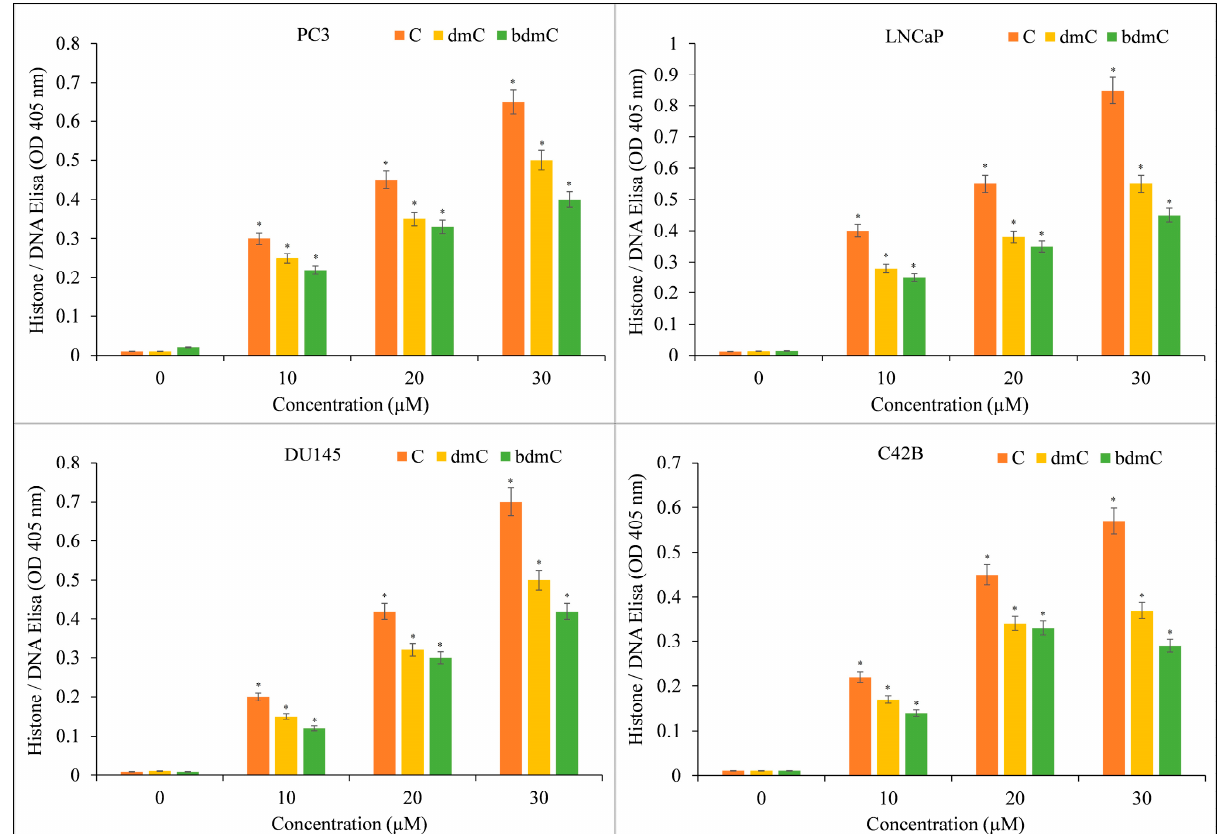
Figure 4. Induction of apoptosis by C, dmC, and bdmC in several cancer cell lines. The Cell Death Detection ELISA Kit (Roche, Palo Alto, CA, USA) was used to detect apoptosis in cancer cell lines after 72 h of incubation with increasing concentrations of curcuminoids, as shown in the figure and detailed in Section 2. The stated values are the ±S.E.M. of three separate experiments. * p value < 0.05 in comparison to the control group.